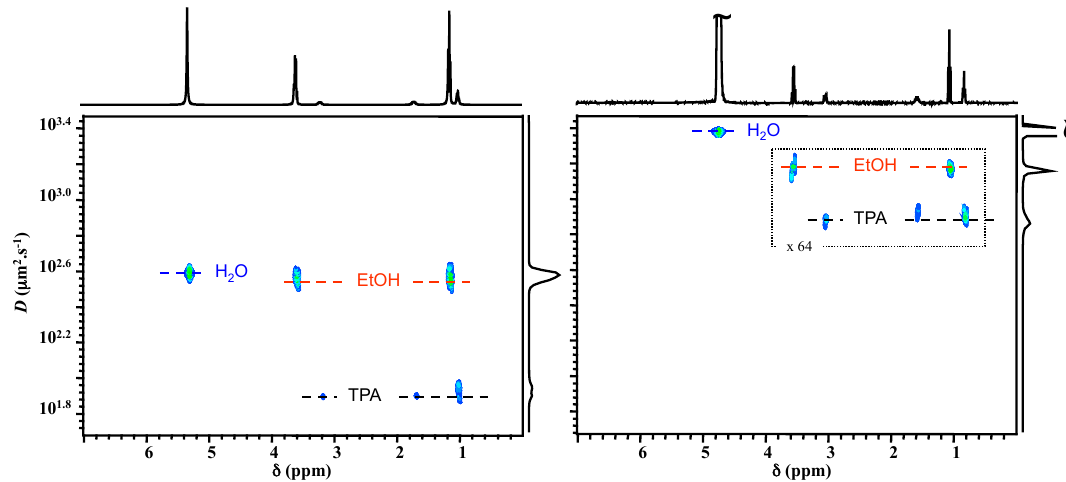
Figure 3. 1 H DOSY NMR spectra obtained for the systems 25 TEOS:9 TPAOH:152 H 2 O ( left ); and 25 TEOS:9 TPAOH:15,000 H 2 O ( right ).